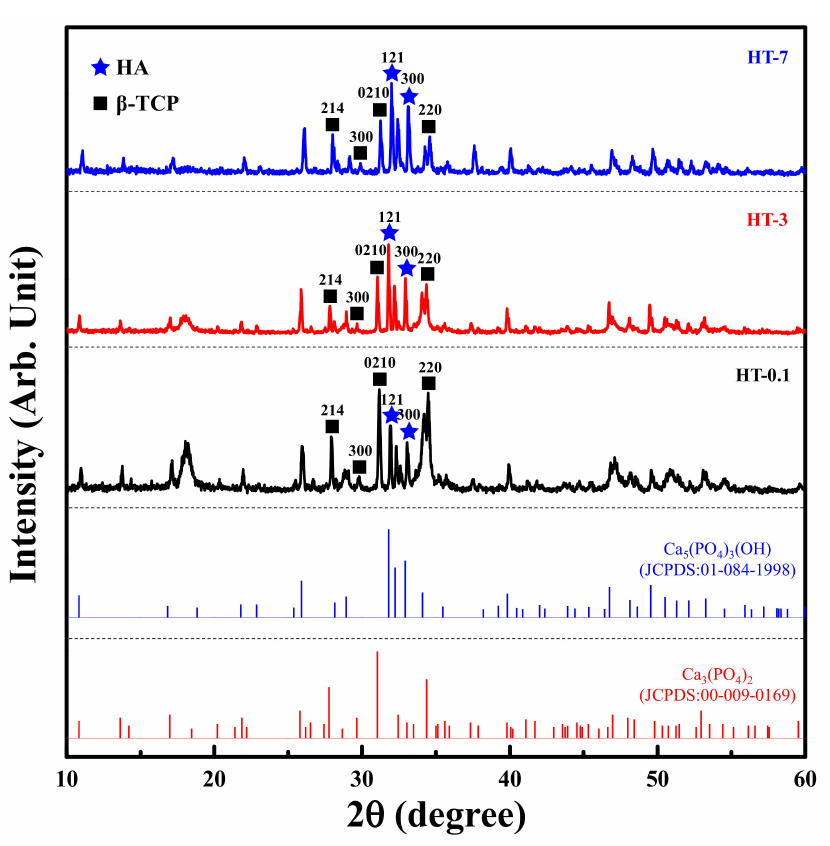
Figure 5. XRD patterns of the samples prepared by the heat treatment of as-prepared coral and DCPA at various durations, including reference spectra for JCPDS 01-084-1988 and 00-009-0169.